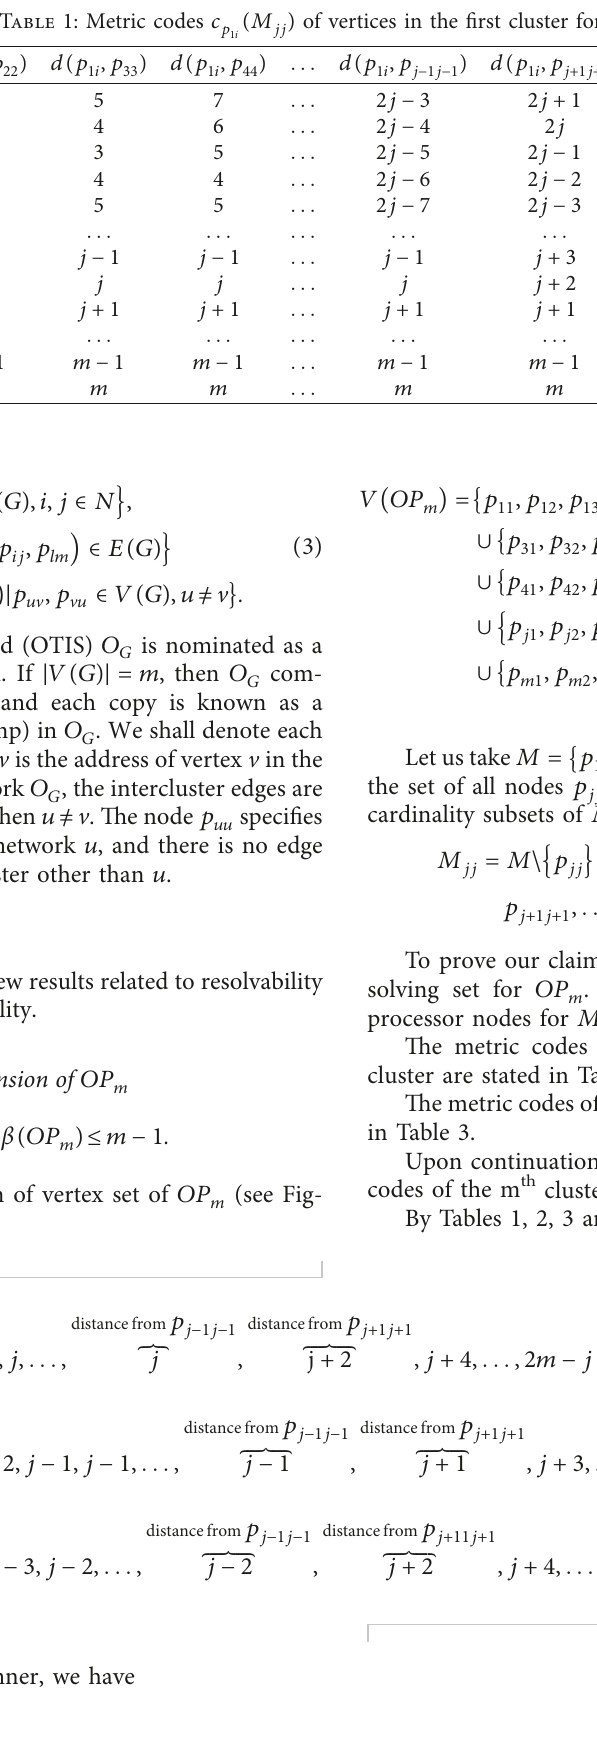
Table 1: Metric codes c